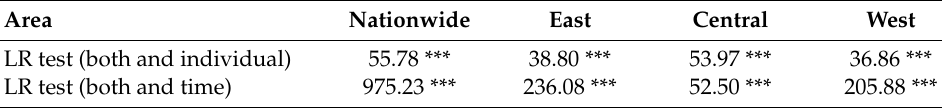
Table 6. Joint significance test results.